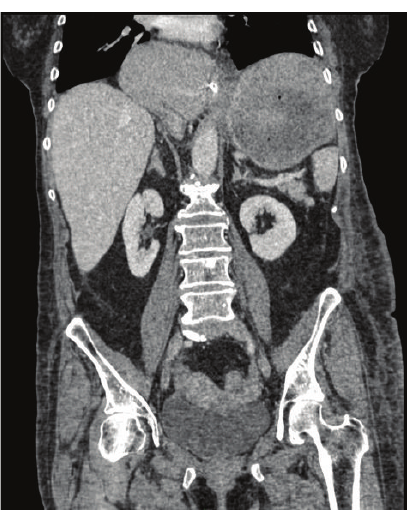
Figure 1: Coronal CT showing herniated stomach above the dia- phragm (arrow).